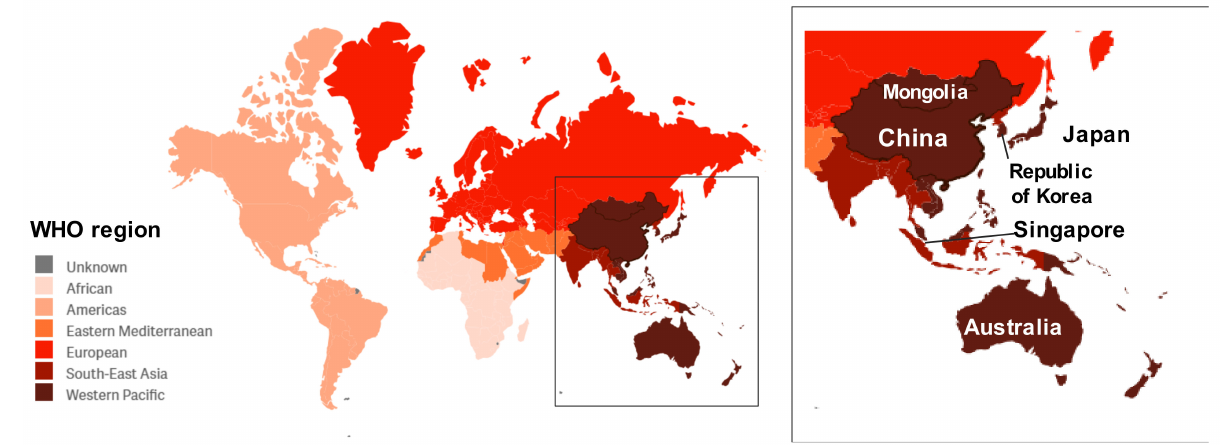
Figure 1. Map of the influenza transmission zones as defined by the WHO. The Western Pacific countries are indicated in dark red. Inset labels the six countries where A(H3N2) were the dominant strain from 2010 week 21 to 2020 week 20. Map downloaded and modified from: https://www. atlasofms.org/map/china/country-classification/who-region# (accessed on 25 November 2021). Table 1. Frequency of laboratory-confirmed influenza cases by influenza virus type and subtype captured by FluNet from 2010 week 21 to 2020 week 20 in 13 countries of the Western Pacific region with populations greater than 1 million a